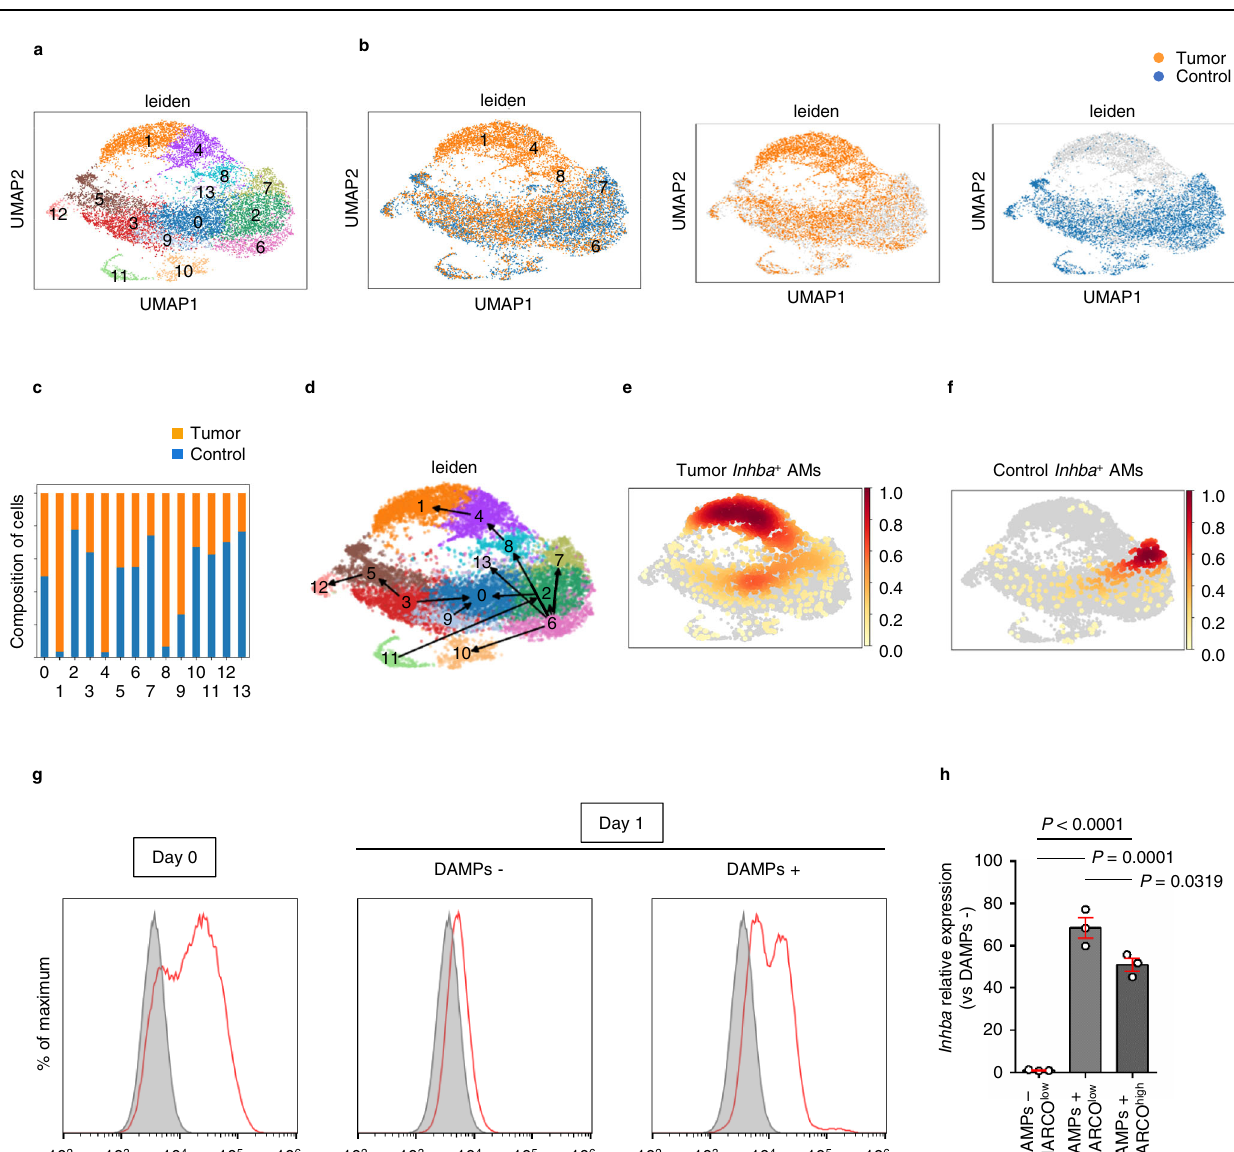
Fig. 3 | Single-cell RNA-seq identi fi es a subtype of tumor-supporting alveolar macrophages(AMs)withhighexpressionofINHBA.a – c UMAPplotofsingle-cell RNA-seq data of AMs from control and tumor-bearing mice. a A total of 13,413 AM cell transcriptomes were analyzed and hierarchically clustered into 14 subgroups using uniform manifold approximation and projection (UMAP) analysis. b , c Ratio ofAMsisolatedfromcontrolmice(blue)tothoseisolatedfromtumor-bearingmice (orange). d Schematic image of RNA-velocity analysis results with scVelo. e , f Distribution of Inhba gene expression levels in AMs isolated from tumor- bearingmice( e )andthoseisolatedfromcontrolmice( f ),shownusingbinarization